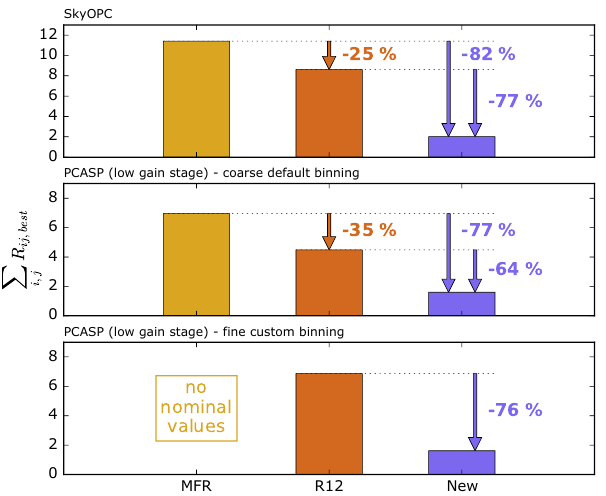
Figure 7. Total sum of residuals between measured relative bin counts and the corresponding model best estimates including all PSL calibration measurements for the SkyOPC and PCASP. In ad- dition to the absolute residual values (solid bars), the arrows and percentage numbers demonstrate the relative reduction by changing the approach.